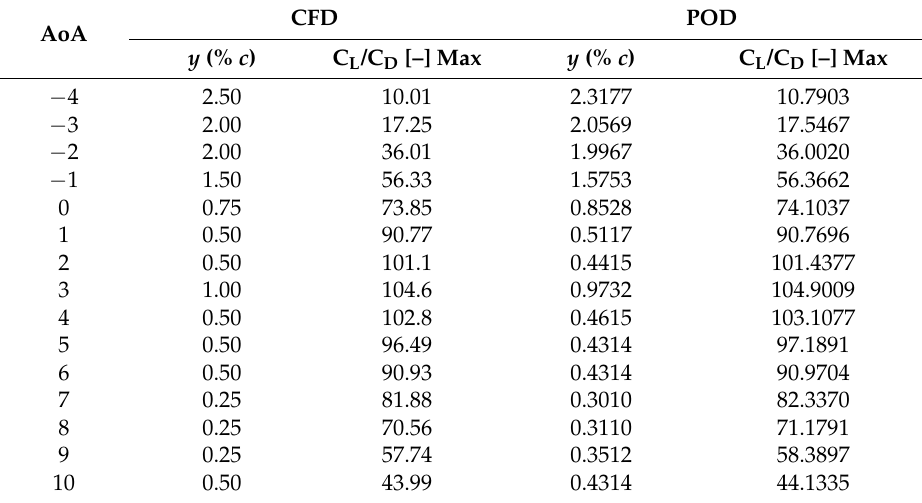
Table 4. Results of the CFD and POD calculations for each AoA of the airfoil which achieved the maximum value of C L /C D with GFs.